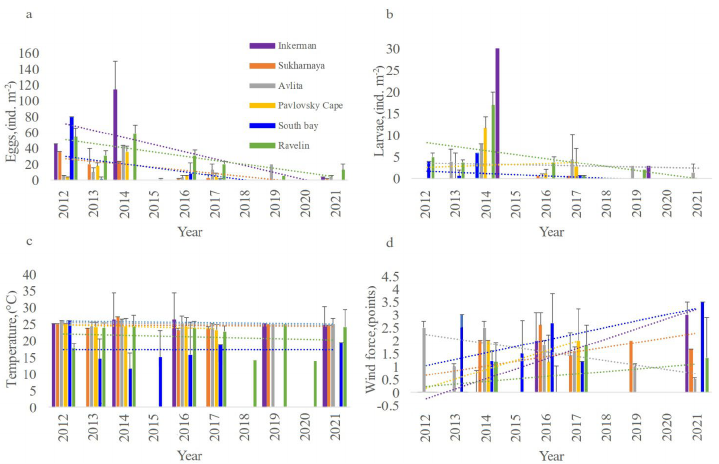
Figure 4. Inter-annual dynamics of the number of eggs ( a ) and larvae ( b ), temperature ( c ), wind strength ( d ) with standard deviations at the Inkerman, Sukharnaya, Avlita, Pavlovsky Cape, South Bay and Ravelin stations in Sevastopol Bay in summer 2012–2021. Dotted lines: linear